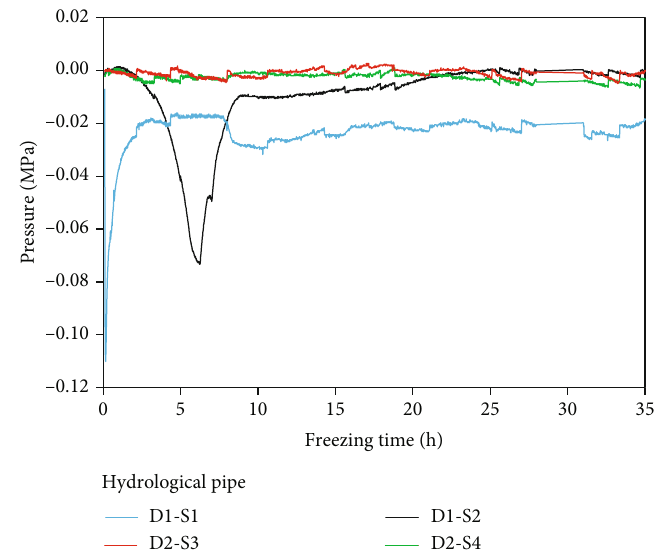
Figure 11: Water pressure in the hydrological